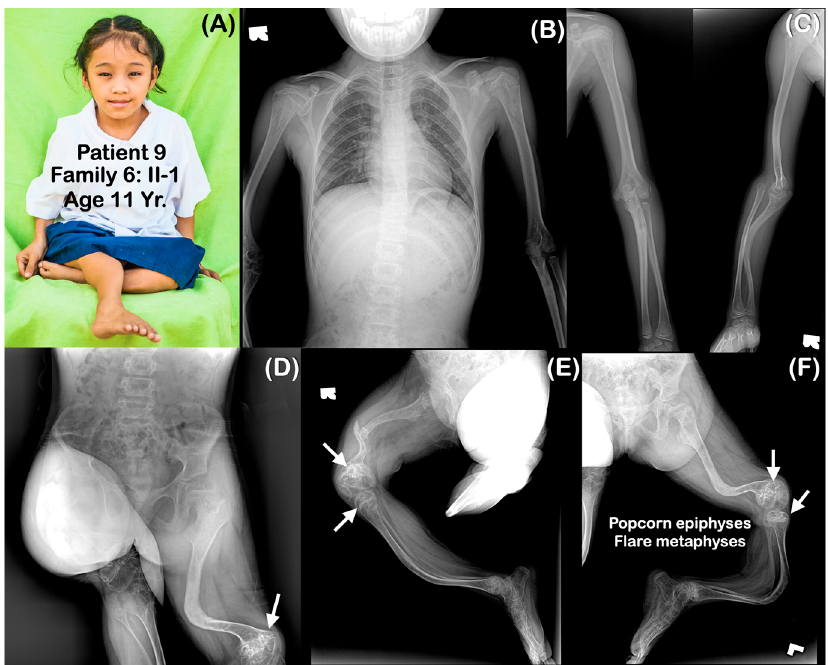
Figure 6. ( A – F ) Family 6. Patient 9 (Family 6: II-1). Age 11 years. Generalized osteopenia. All long bones are slender and curved. Femora are severely shortened. Fracture of right femur is noted. ( D – F ) Popcorn epiphyses and metaphyses at distal femora are visible (arrows).